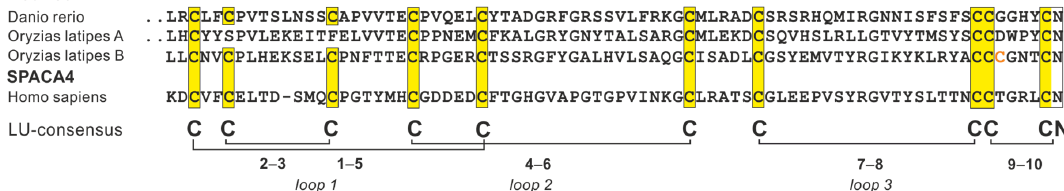
Figure 3. Sequence alignment of bouncer from zebra fish ( Danio rerio ) with two paralogous sequences ( A and B ) from medaka ( Oryzias lapites ). These proteins are expressed by oocytes. The B variant of medaka bouncer contains an unpaired cysteine (highlighted in orange) and lacks a functional C-terminal signal sequence entailing membrane tethering by a GPI-anchor. Also shown is the sequence from the closest human homolog, SPACA4 / SAMP14, expressed in